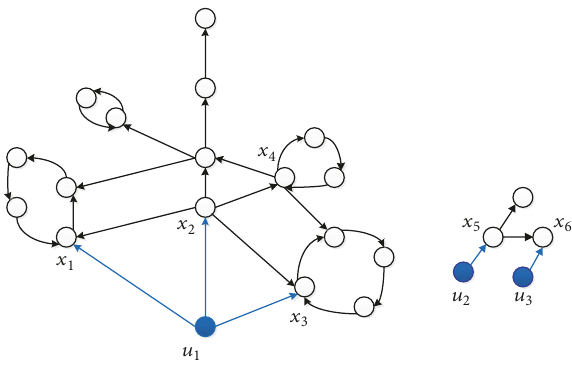
Figure 1: Schematic diagram of a controllable